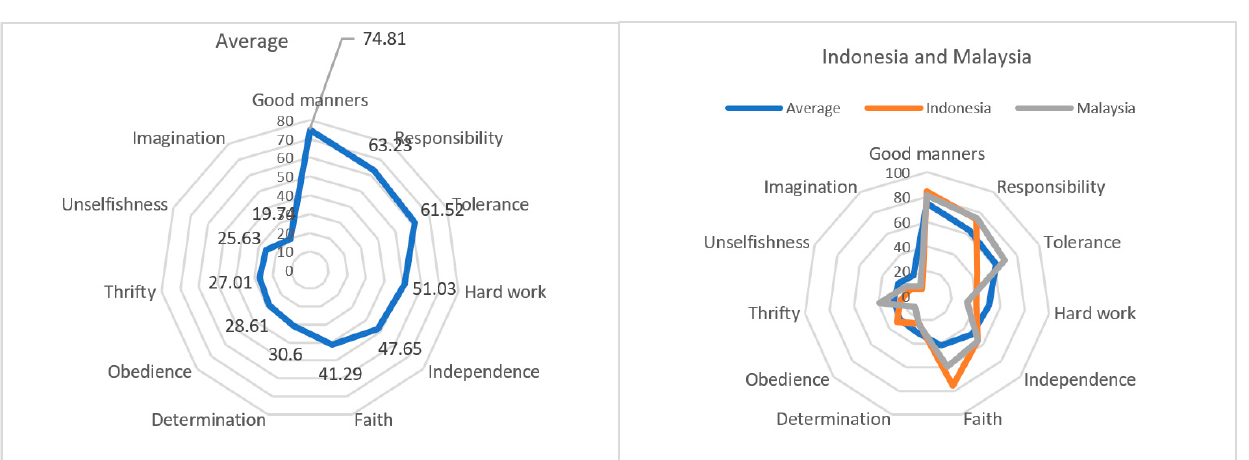
Figure 5. Qualities to develop for the future generation in Indonesia and Malaysia .